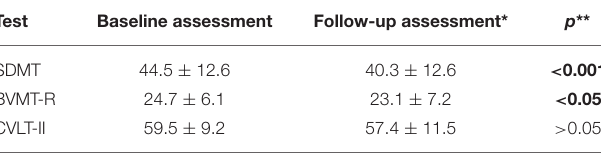
TABLE 1 | Clinical and demographic characteristics of the patients. TABLE 2 | Cognitive scores at baseline and follow-up in patients with